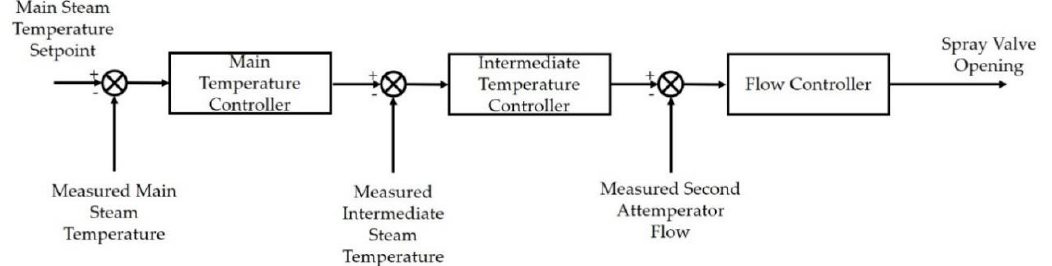
Figure 9. Configuration 2 Control Scheme for Main Steam Temperature.